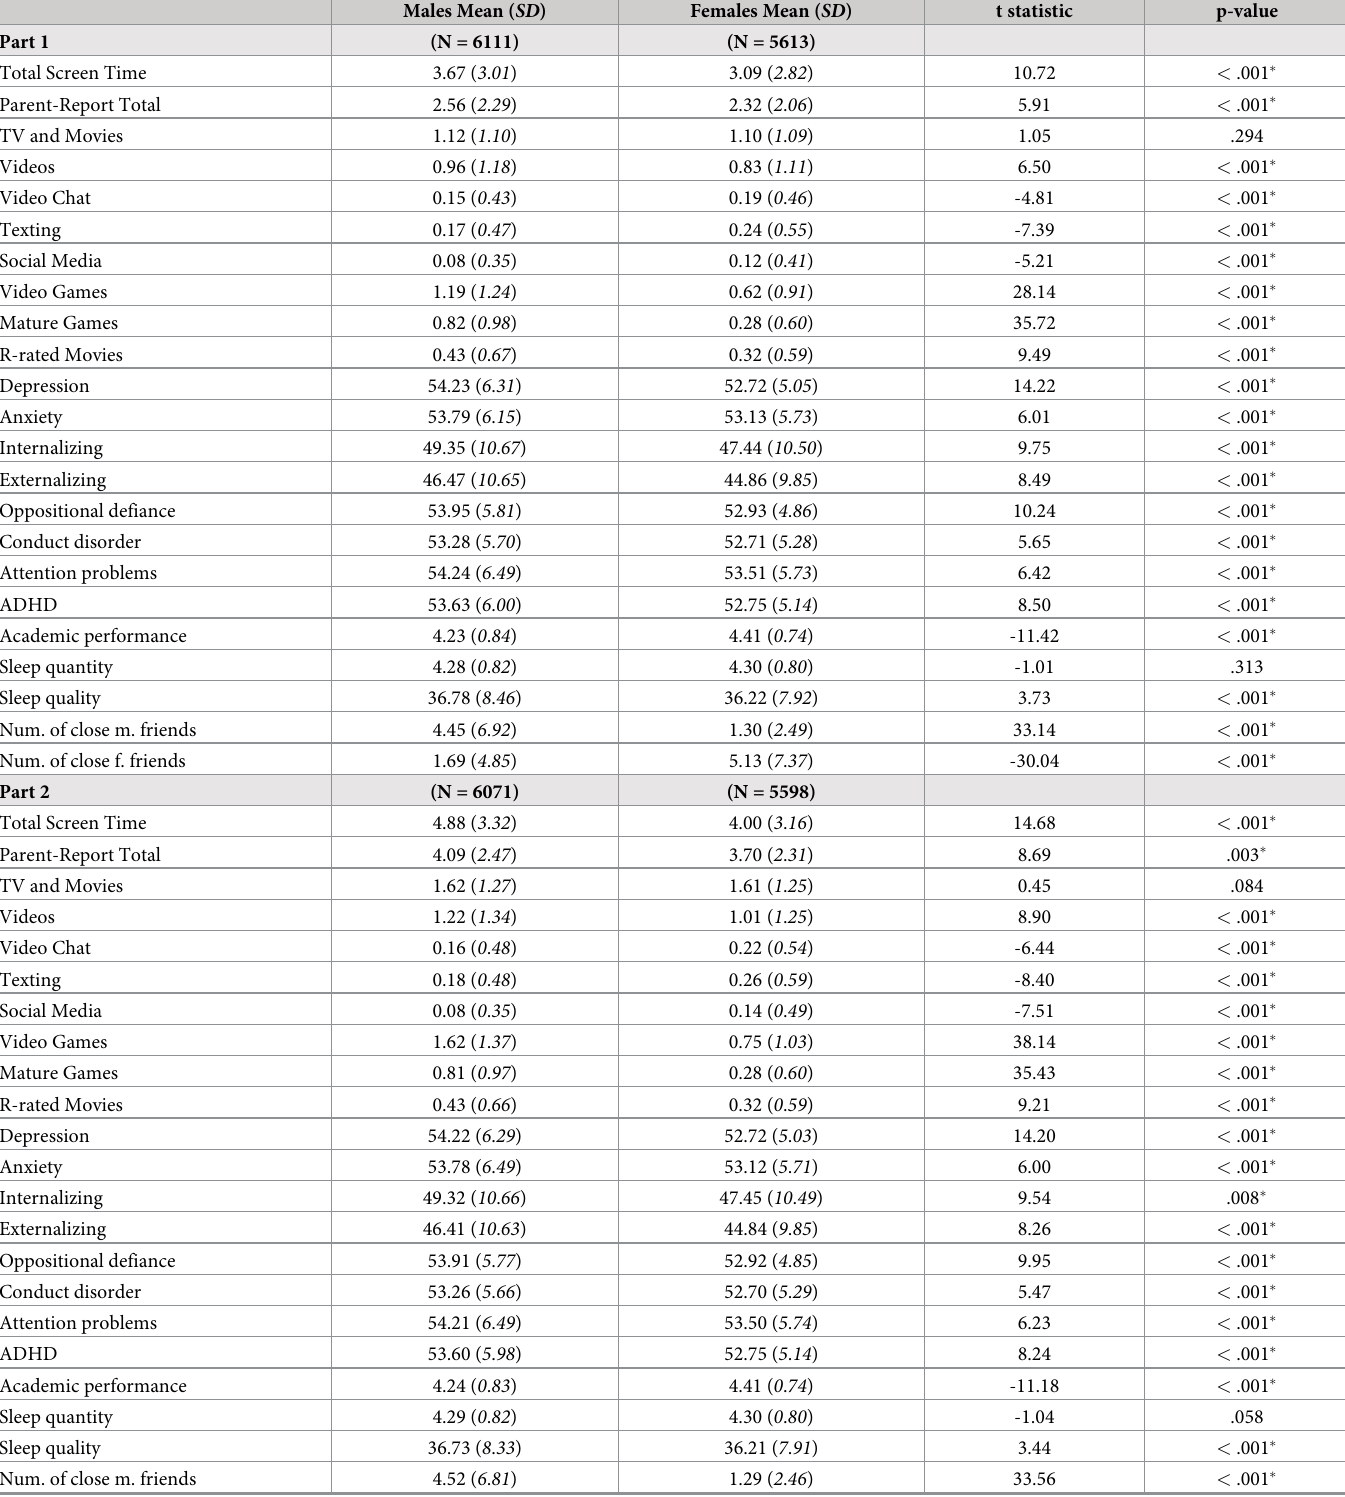
Table 1. Participant sex differences on screen time measures and outcome variables for Part 1 and Part